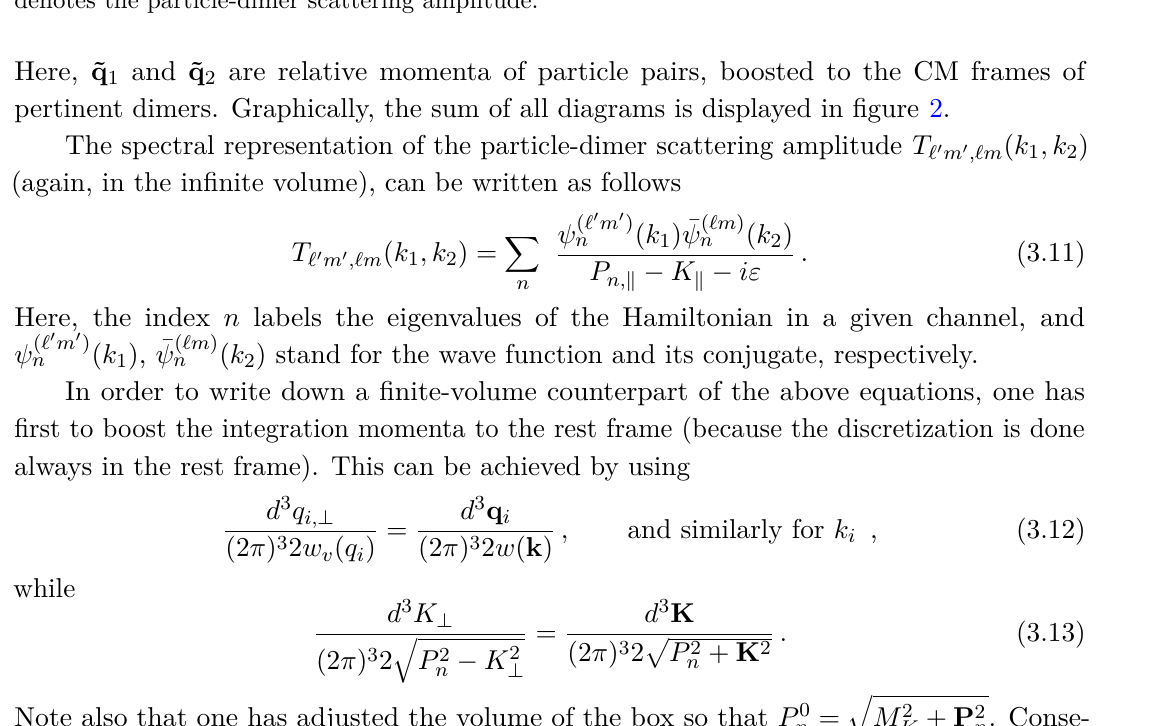
Figure 2 . Two-point function, calculated in the effective field theory. The solid and double lines stand for the one-particle propagator and the full dimer propagator, respectively. The quantity T denotes the particle-dimer scattering